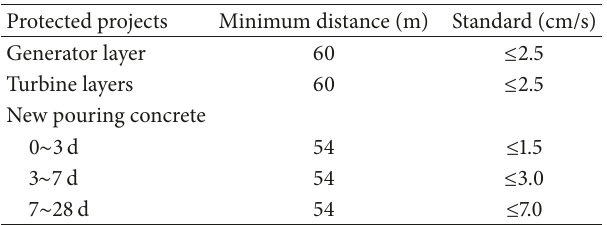
Figure 12: Mechanism of reducing blasting vibration: (a) presplit- ting blasting before draw cut blasting; (b) draw cut with damping ditch. Table 5: Safety control standard of blasting vibration in Fengning pumped storage power